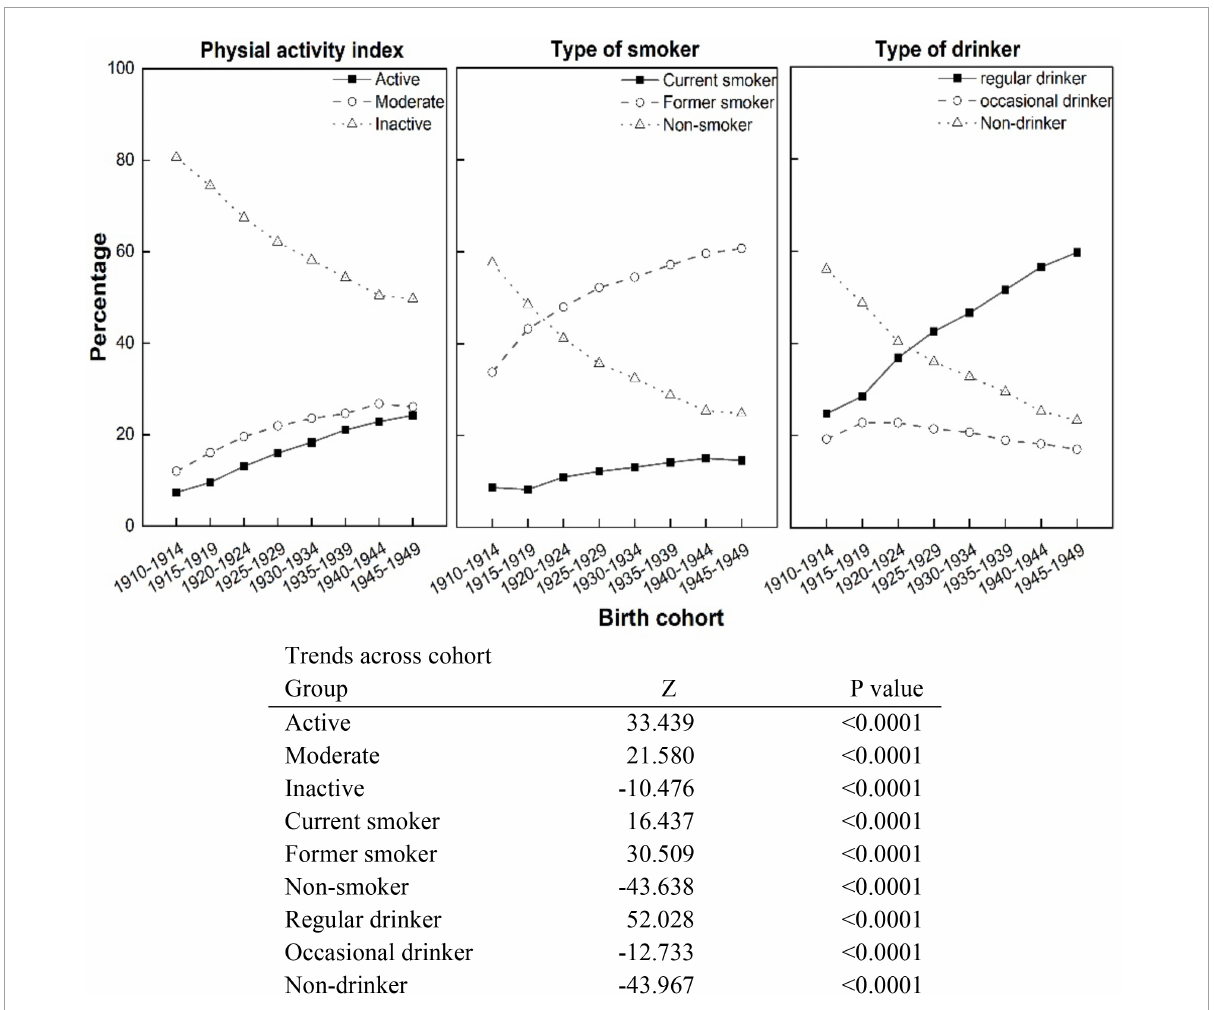
FIGURE1 Trends in physical activity index, smoking status, and type of drinker across birth cohorts, from the 1910s to 1940s, Canadian residents